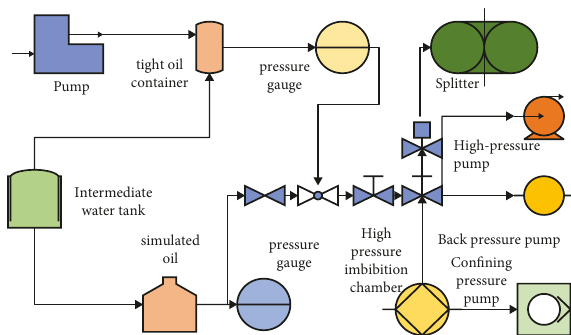
Figure 4: Dynamic imbibition physical simulation experiment.